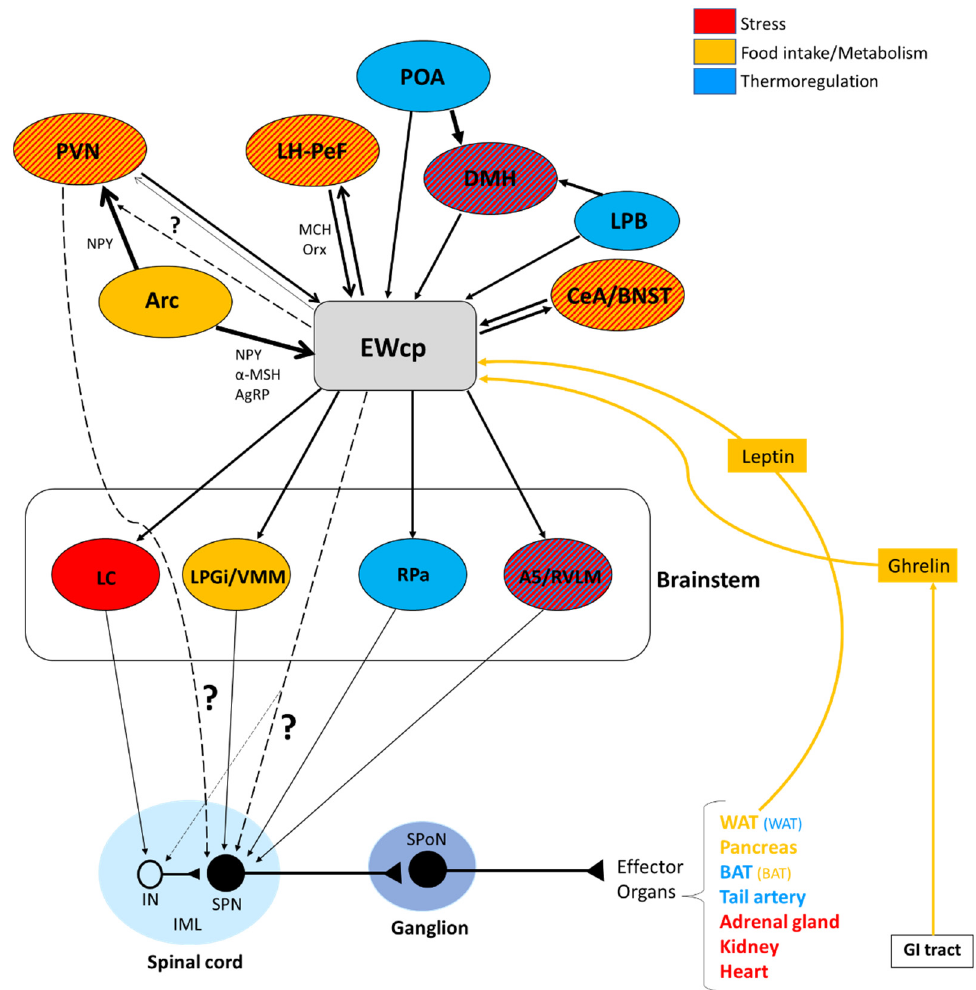
Figure 12. Proposed model for EWcp as an integrator of multimodal signals and modulator of sympathetic output to multiple effector organs to maintain energy homeostasis in rodents under different conditions. Brain regions and effector organs are color coded by the main function with which they are involved. Brain regions that are implicated in two functions are depicted by two colors. Similarly, effector organs involved in two functions are noted in large fonts for main functions and in smaller fonts for secondary roles. Arrow thickness represents projection density based on literature. Dashed lines (with question marks) represent hypothetical pathways based on neuroanatomical data, but without physiological information yet to support their role in the EWcp circuit. For example, the effect of Ucn-1 from EWcp in PVN could occur directly or via presynaptic activation of CRF-R2 on NPY terminals from Arc. In addition, it is unknown if this effect of Ucn-1 in PVN might affect the activity of presympathetic neurons known to project directly to SPNs in the spinal cord. The direct projection from EWcp to the spinal cord (to SPNs or interneurons) has been reported in classical tracing studies; nevertheless, transneuronal retrograde tracing with PRV does not support this direct projection (or if it exists, it is very sparse). For clarity purpose, the figure only includes relevant neuroanatomical connections from/to EWcp in the brain, excluding most connections among other brain regions. Abbreviations: GI, gastrointestinal; IN, interneurons; LPB, lateral parabrachial nucleus; LPGi, lateral paragigantocellular nucleus; POA, preoptic area; SPoN, sympathetic postganglionic neurons. For the rest of the terms, see the list of